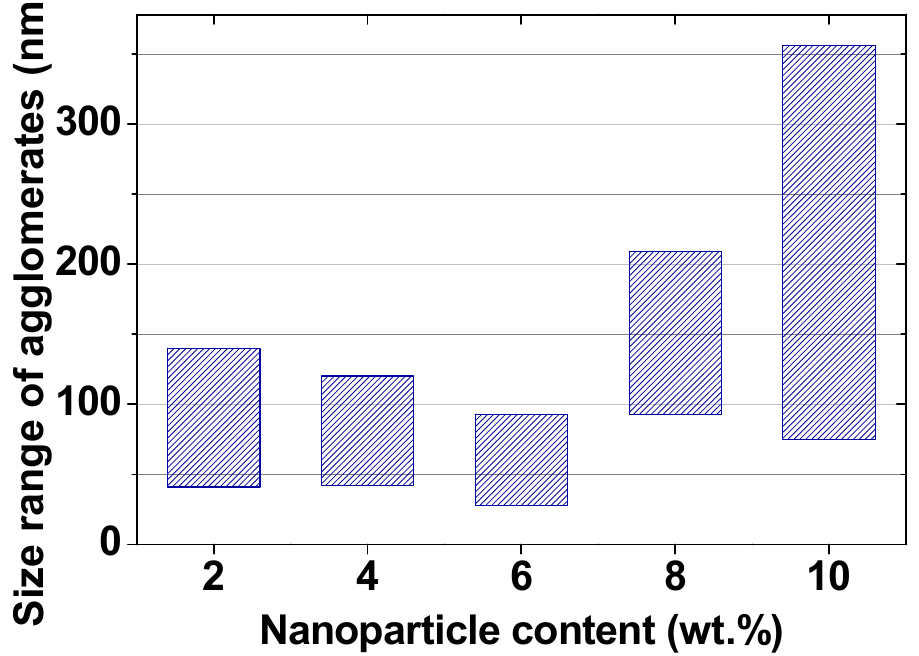
Figure 7. Size range of nanoparticle agglomerates of nanocomposites. Figure 8a–f show the 2D image of the microstructure of the pure matrix and nanocom- posite surfaces, respectively. There are two images for each sample. The first image (bottom) is the topography, which describes the sample roughness and microstructure. The second image was obtained in the lateral force mode or in the contact mode of the atomic force microscopy peaks. The second image (overhead) demonstrates the magnitude of the forces that twist the AFM probe during scanning. These forces are most-often associated with frictional forces, as they impede the movement of the tip of the probe over the surface under study [84–86]. However, friction at the nanoscale has a more complex nature than at the macroscale. At the macroscale, the main contributor to friction is surface roughness. At the nanoscale, the force of adhesion; interatomic and intermolecular interactions (van der Waals force); and electrical, magnetic, and chemical interactions also have a strong effect. The contribution of each of these components to nano-friction processes is poorly understood and little-studied in the literature due to its complex influence. However, it can be asserted, with complete confidence, that individual sections of composite images with a 2, 4, and 8 wt.% of MZFA filler interact with an AFM probe at different strengths. This is confirmed by the contrasting areas in the lateral forces maps’ overhead images for nanocomposite with a 2, 4, and 8 wt.% of filler in Figure